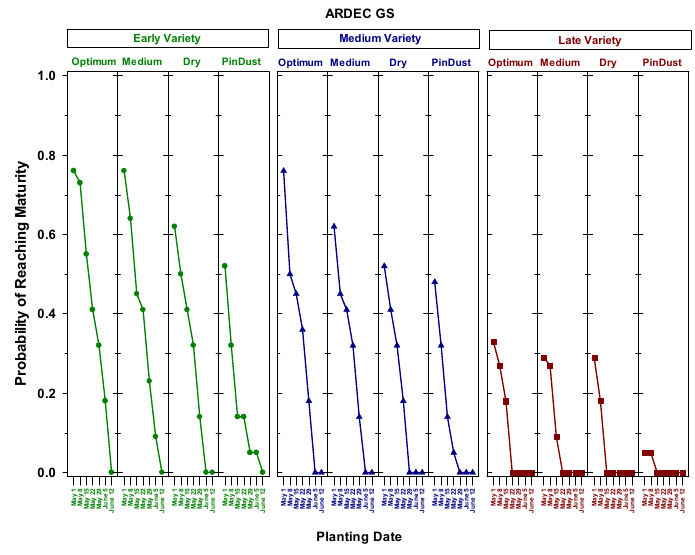
Figure 5. Probability of sorghum reaching physiological maturity at ARDEC, Colorado, for seven planting dates using non-stressed (GS) phenological parameters, three maturity classes, and four seedbed water conditions at planting.